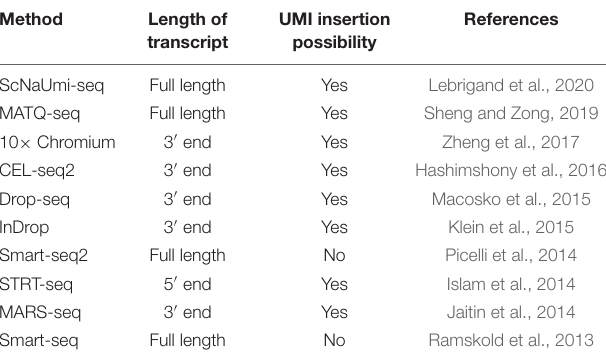
TABLE 1 | Current SC-RNA-seq profiling techniques, based on transcript coverage and UMI insertion